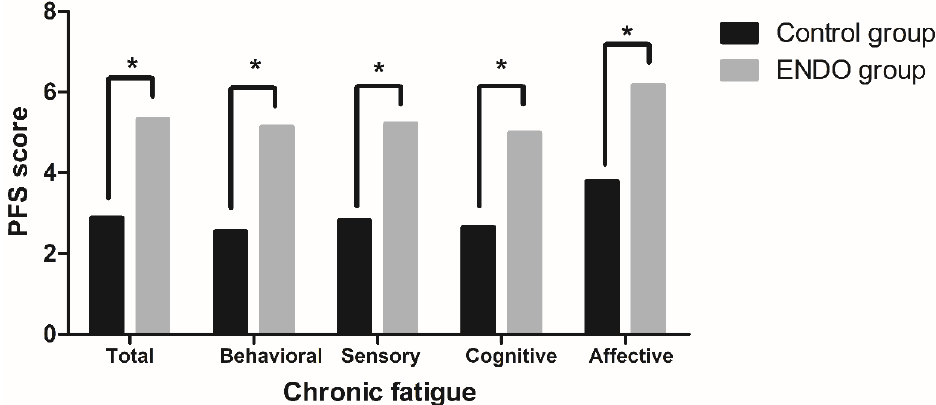
Figure 1. Levels of endometriosis-related fatigue (ERF) in women with (ENDO group) and without endometriosis (control group). PFS: Piper Fatigue Scale. p -values were calculated through the Mann–Whitney U. * p - value < 0.050.